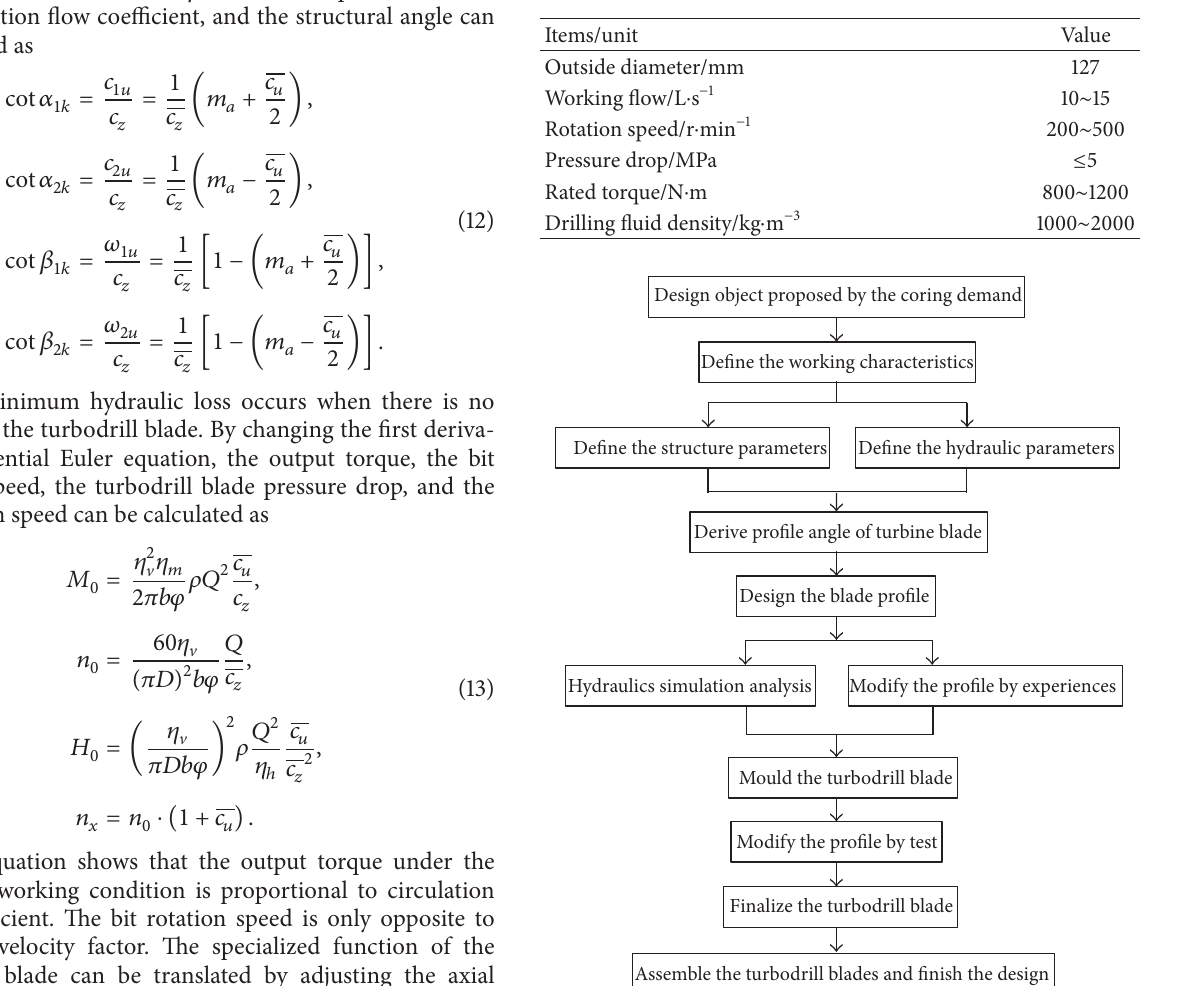
Table 1: Target performance parameters of turbodrill ( B 127 ).